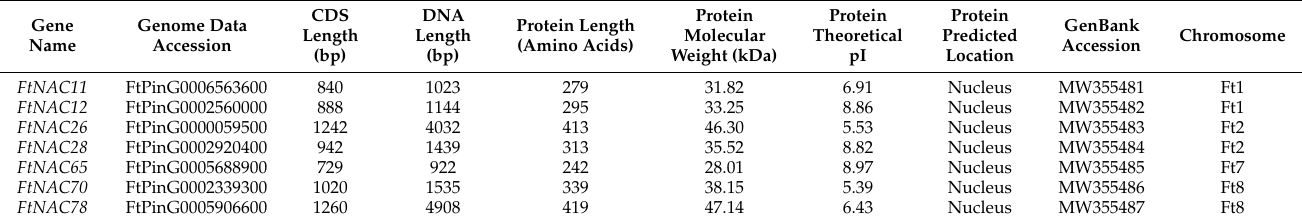
Table 1. Overview of seven FtNACs identified in Tartary buckwheat.